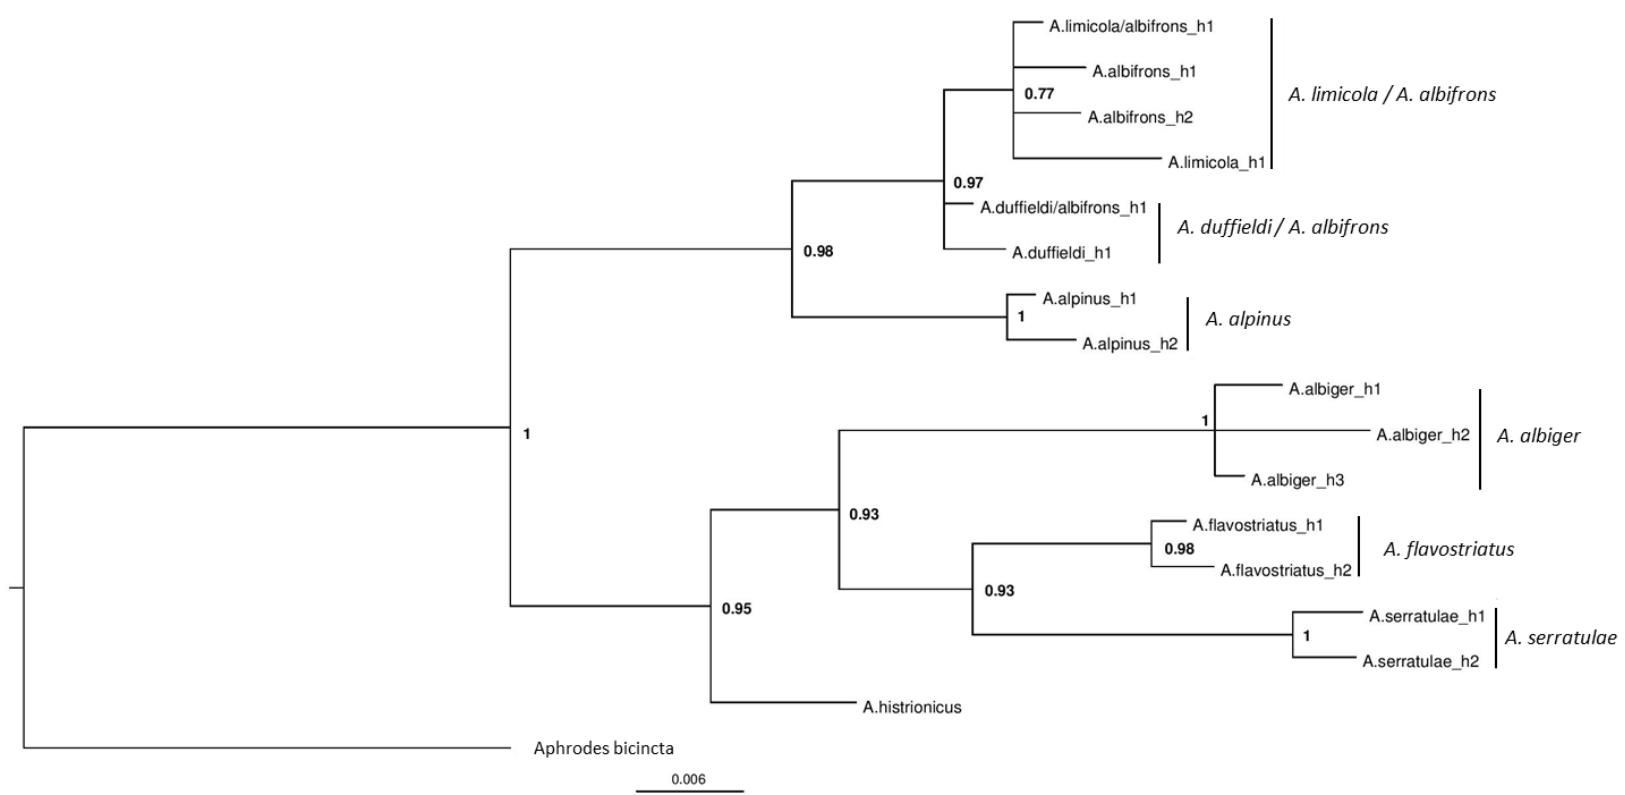
Figure 3. Bayesian phylogeny based on mitochondrial 16S rRNA data. Haplotypes were identified in DnaSP v5.10.01 [55] from individual sequences, with species names separated by ‘ / ’ indicating shared haplotypes across two di ff erent species. Bayesian posterior probabilities are labelled at each node with the whole tree rooted by using the closely related Aphrodes bicincta as an outgroup .